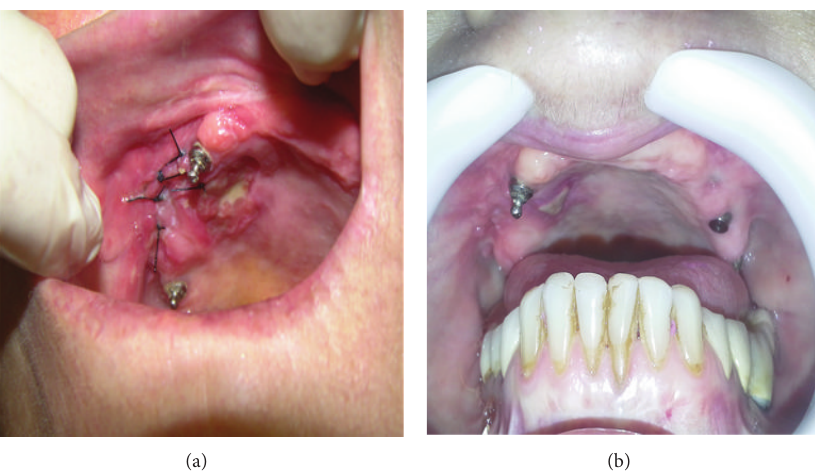
Figure 3: Clinical aspect (a) at one week and (b) one month after the surgery for communication